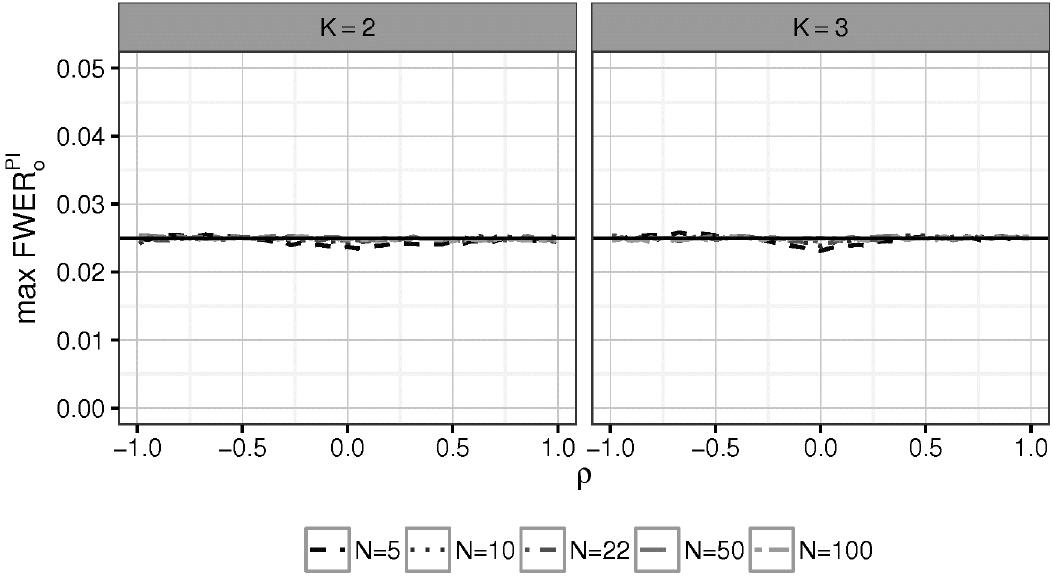
Fig 2. Simulated values of worst case FWER PI as a function of ρ . Two treatments were comparedto one common o control with equal per-groupsample sizes n . A conservative behavioris visiblearound0, when the per-groupsample size is